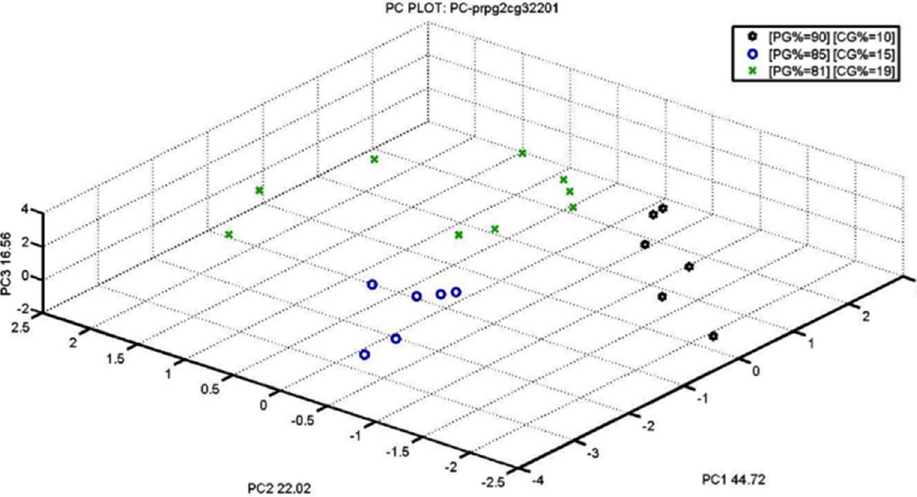
Figure 3. PCA Score PLOT for different crust percentage (10%, 15%, and 19%).